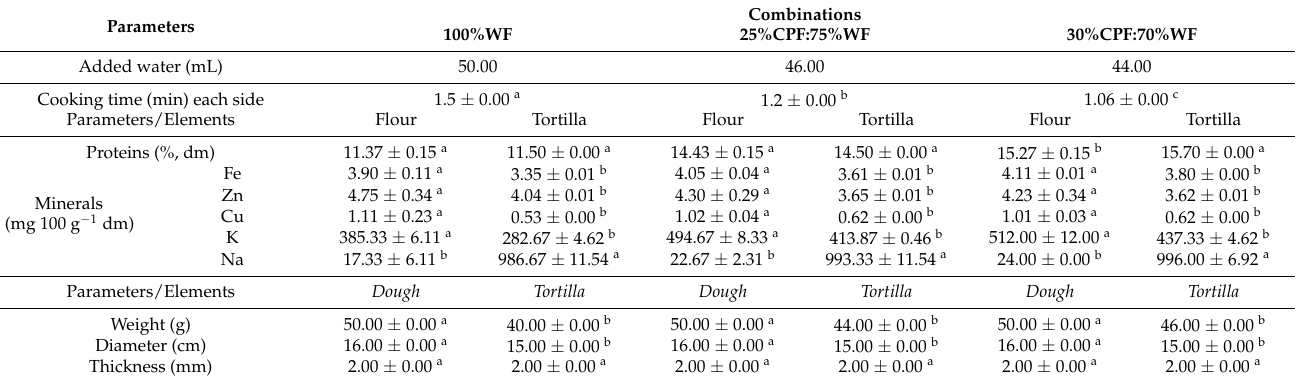
WF: durum wheat flour; CPF: chickpea flour. Values are mean ± SD ( n = 3). Means with different superscript letters for the same parameter and ratio indicate significant statistical differences, p -value ≤ 0.05.